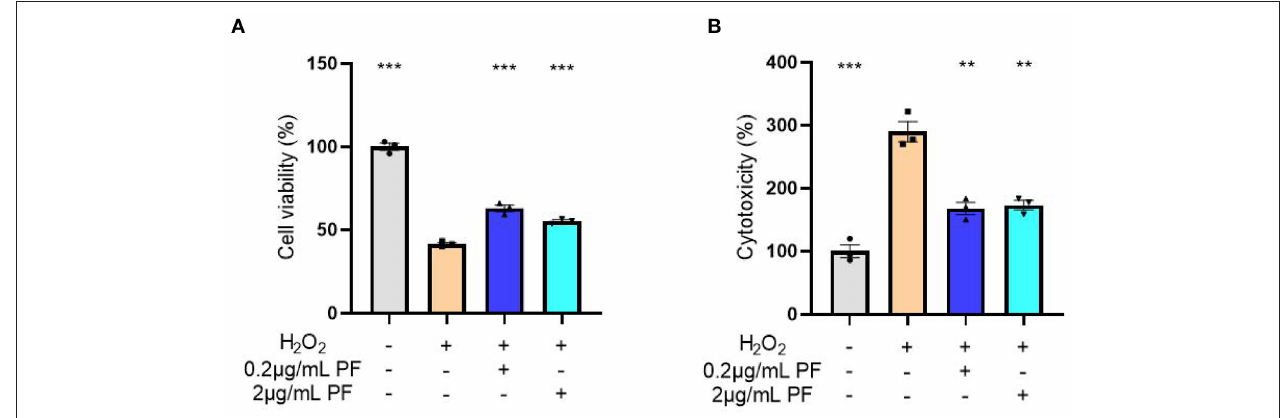
FIGURE 4 | Paeoniflorin (PF) protected against oxidative stress-induced neurotoxicity in primary cultured hippocampal neurons. (A) The cell viability of primary cultured hippocampal neurons was markedly decreased after hydrogen peroxide treatment when compared with control group ( P < 0.001). However, the severity of this decrease in cell viability was significantly reduced when the neurons were pretreated with 0.2 µ g/ml ( P < 0.001) and 2 µ g/ml ( P < 0.001) PF. (B) Analysis of LDH release, as a measure of cytotoxicity, demonstrated that hydrogen peroxide caused significantly increased cytotoxicity in the primary cultured hippocampal neurons, whereas treatment of 0.2 µ g/ml ( P < 0.001) and 2 µ g/ml ( P < 0.001) PF in the neurons significantly reduced the severity of the cytotoxicity. Three-way ANOVA statistics: F